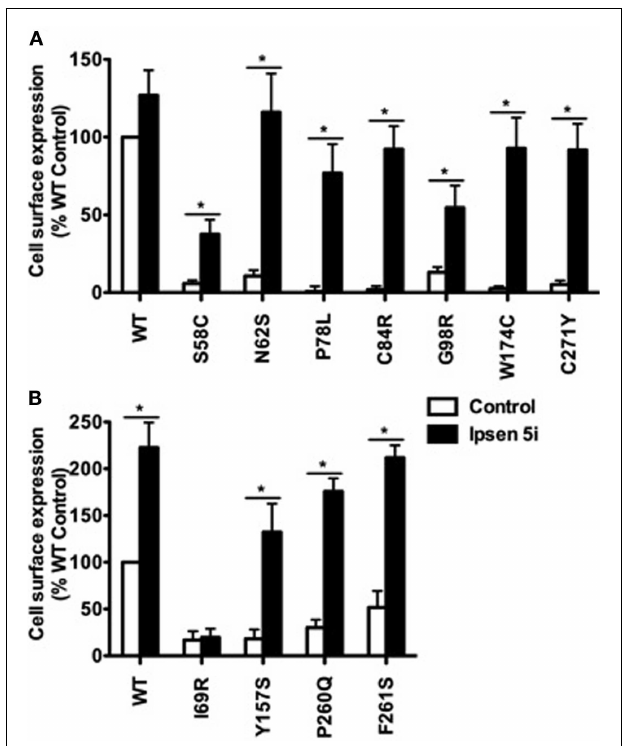
FIGURE 3 | Ipsen 5i rescued the cell surface expression of intracellularly retained mutant MC4Rs in HEK293 cells as quantitated by flow cytometry . HEK293 cells stably expressingWT or mutant MC4Rs were treated with 10 − 5 (A) or 10 − 6 (B) M Ipsen 5i for 24h and then stained with Alexa Fluor 488-conjugated antibody.The immunostaining was measured using a C6 Accuri Cytometer.The results are expressed as % DMSO-treatedWT cell surface expression level after correction of the non-specific staining in cells expressing the empty vector. Results are shown as mean ± SEM of at least three independent experiments. *Significantly different from the DMSO-treated control group, p < 0.05.